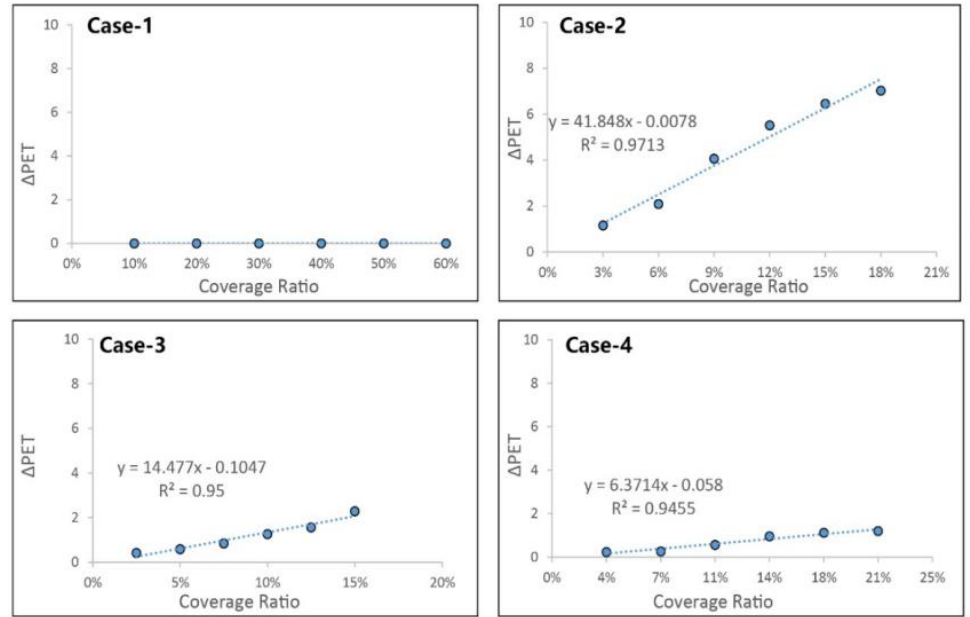
Figure 17. Correlation between thermal comfort and coverage ratio of different parameter in open space at 3:00pm.